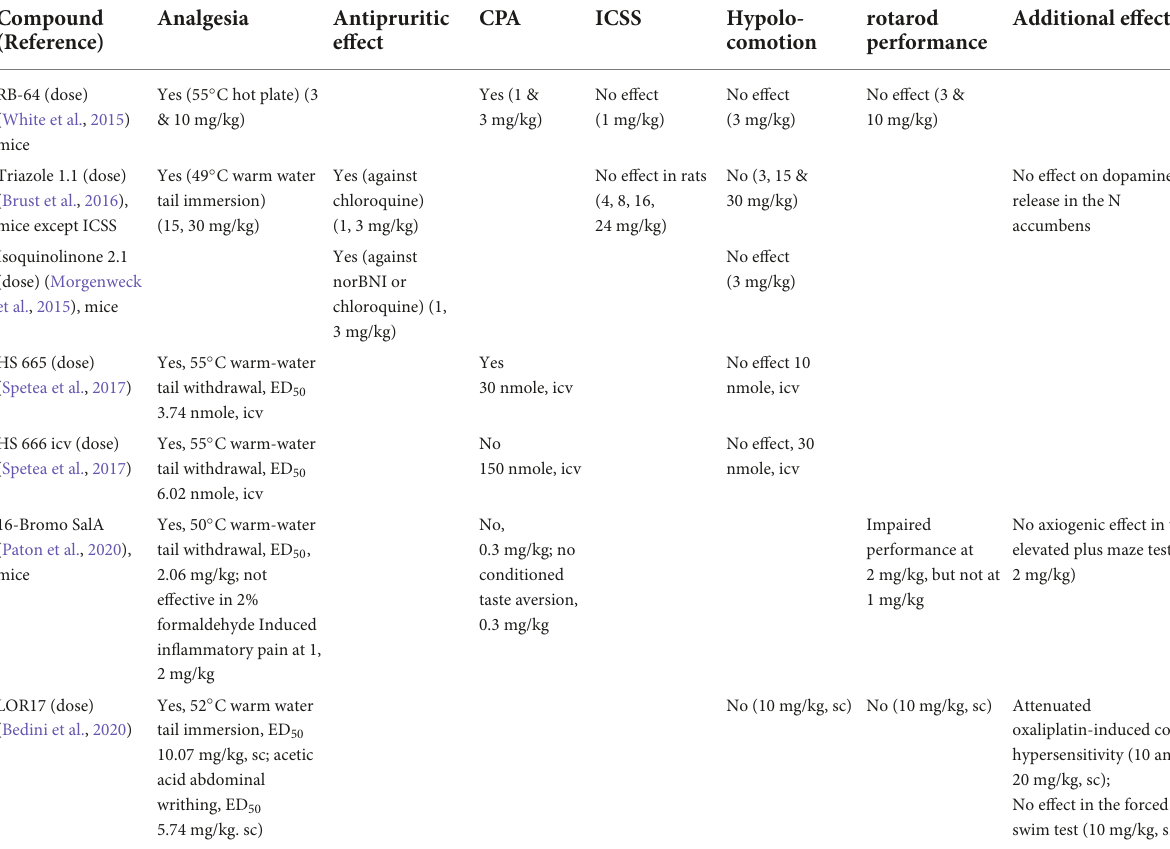
TABLE 4 In vivo pharmacological characterization of some G protein-biased KOR agonists in rodents. Compound Analgesia Antipruritic (Reference)